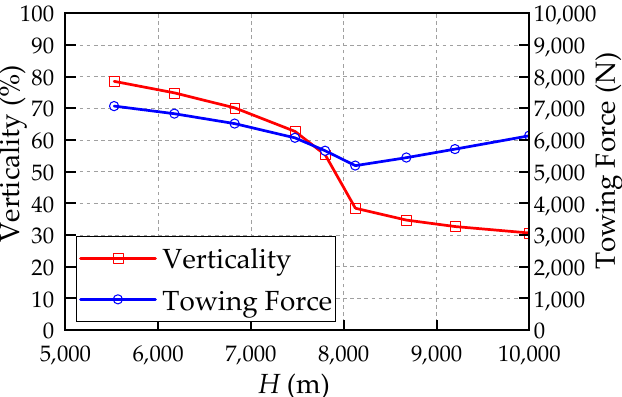
Figure 15. Verticality and towing force vs. orbit altitude.